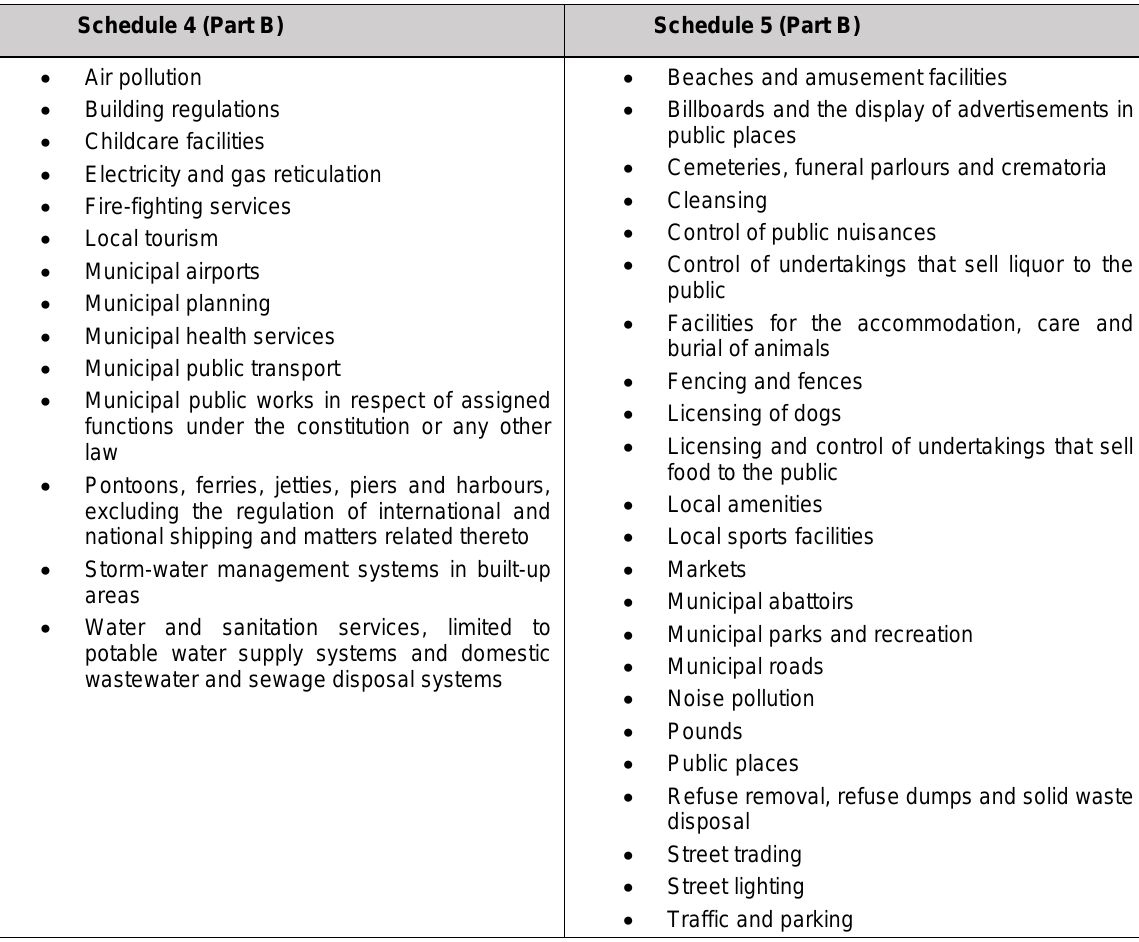
Table 3: Constitutional responsibilities of